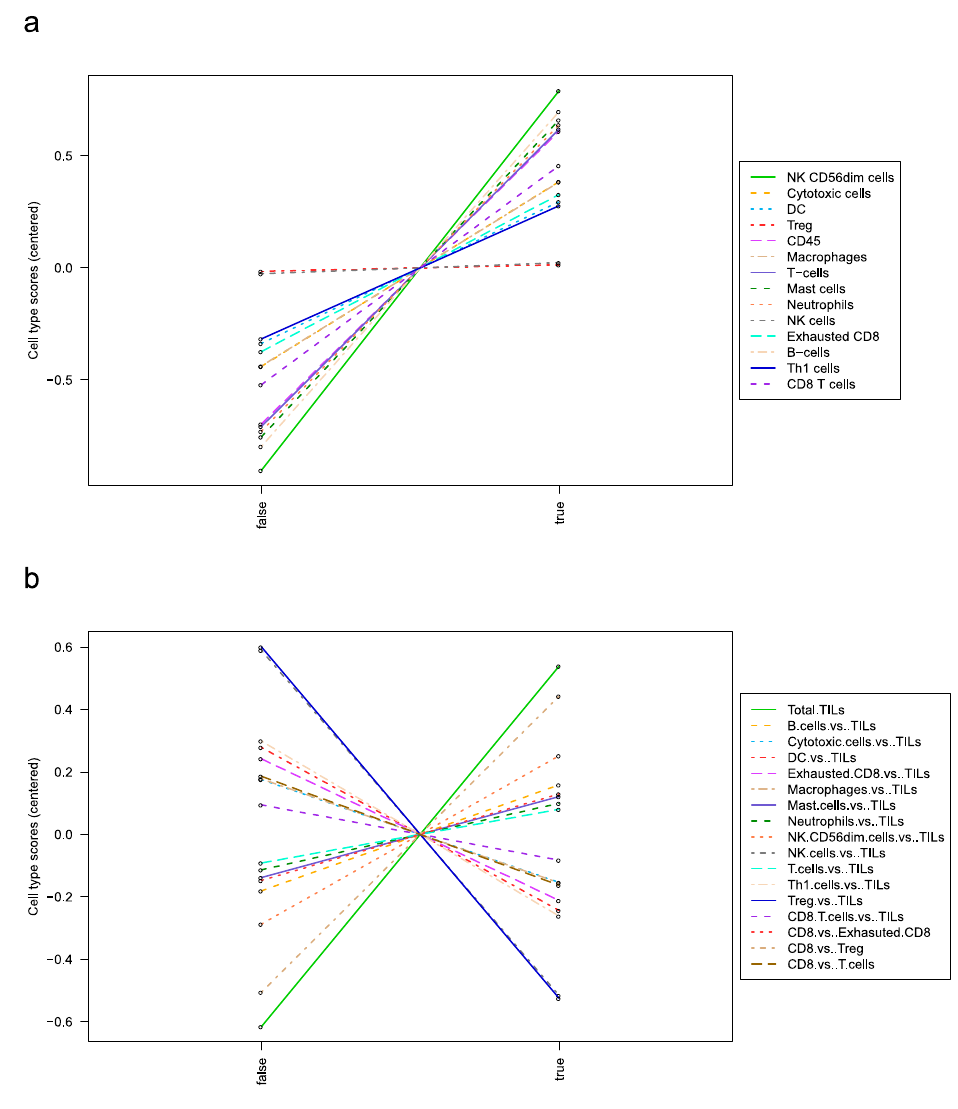
Figure 4. Cell type profiling reveals increased immune infiltrates in responders. ( a ) Absolute and ( b ) relative cell type scores are shown in responders (true) and non-responders (false). The nCounter ® advanced analysis module of the PanCancer immune profiling panel uses genes whose expression is largely specific to certain immune cell populations to measure the abundance of these cell types. The module assumes that each cell type’s characteristic genes are expressed exclusively and consistently within the cell type. Under this model, a cell type’s abundance can be measured as the average log-scale expression of its characteristic genes. The cell type abundance measurements are plotted against response. True = responder, false =